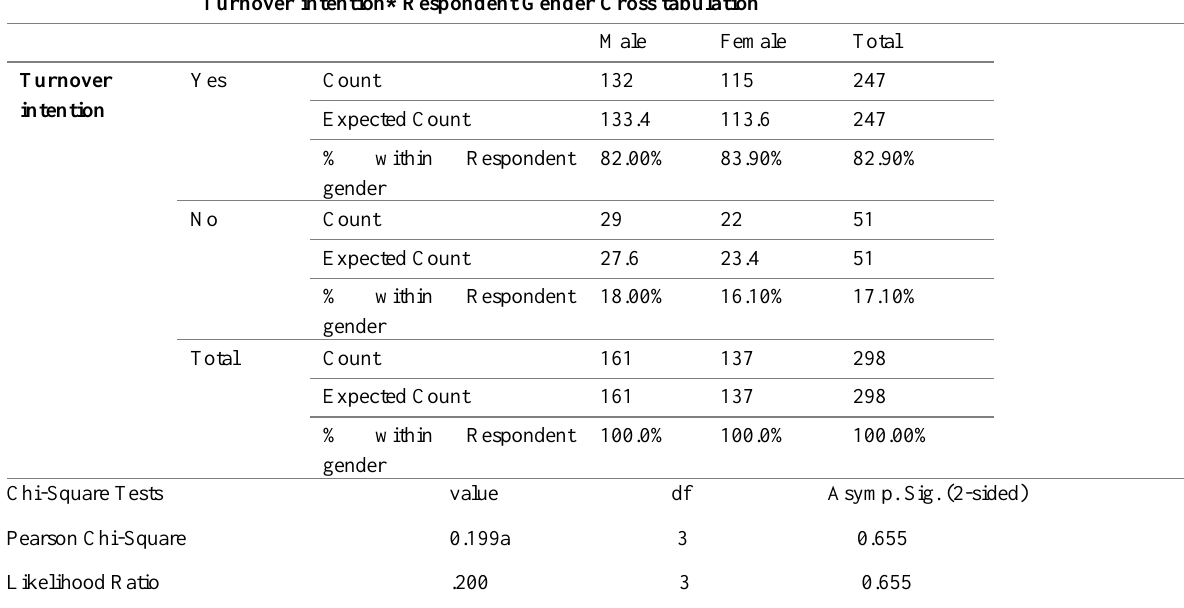
Table 4: Cross Tabulation of Turnover Intentions and Gender